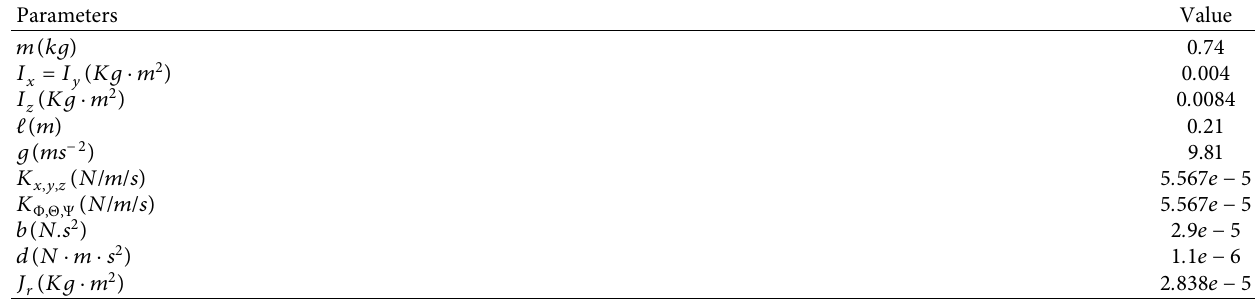
Table 1: Quadrotor’s parameters [46].